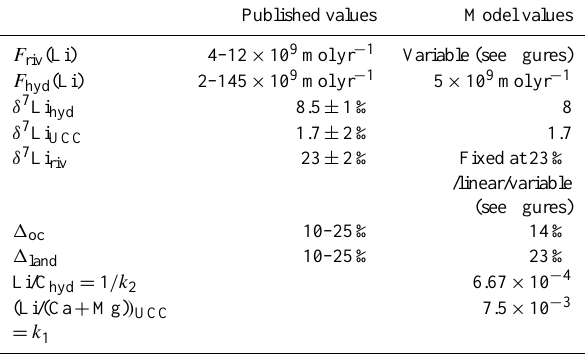
Table 2. Parameters used in the model. (cid:49) oc and (cid:49) land (Li isotope fractionation during secondary phase formation in the ocean and on land, respectively) are chosen from within the published range such that (1) the seawater paleo-variation exactly matches the 5My fit of the Misra and Froelich (2012) foraminifera data through the Cenozoic (65–0Ma) (shown in Fig. 1) and (2) at time t = 0 (present day), both F riv (Li) and δ 7 Li riv values must be within the published range (see text for references).